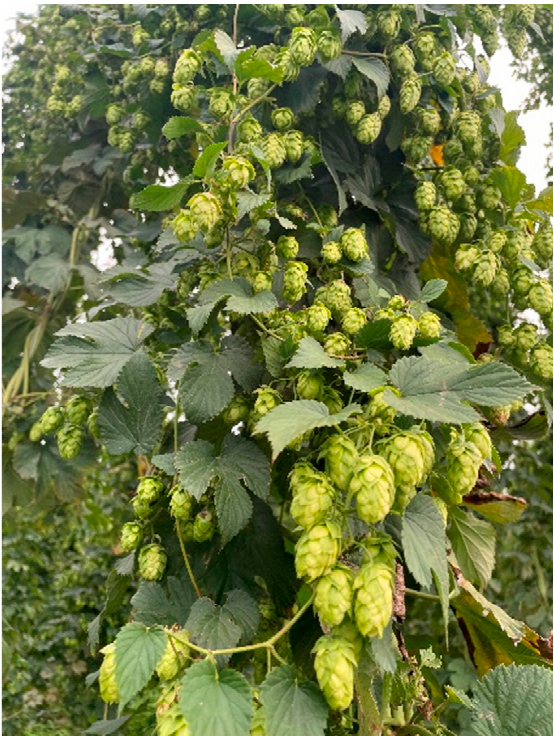
Figure 1. Hop cones of the female hop plant ( Humulus lupulus L.) cv. Aurora. Photo credit: Katja Bizaj—Hop field in Slovenia in pre harvest season of year 2021.